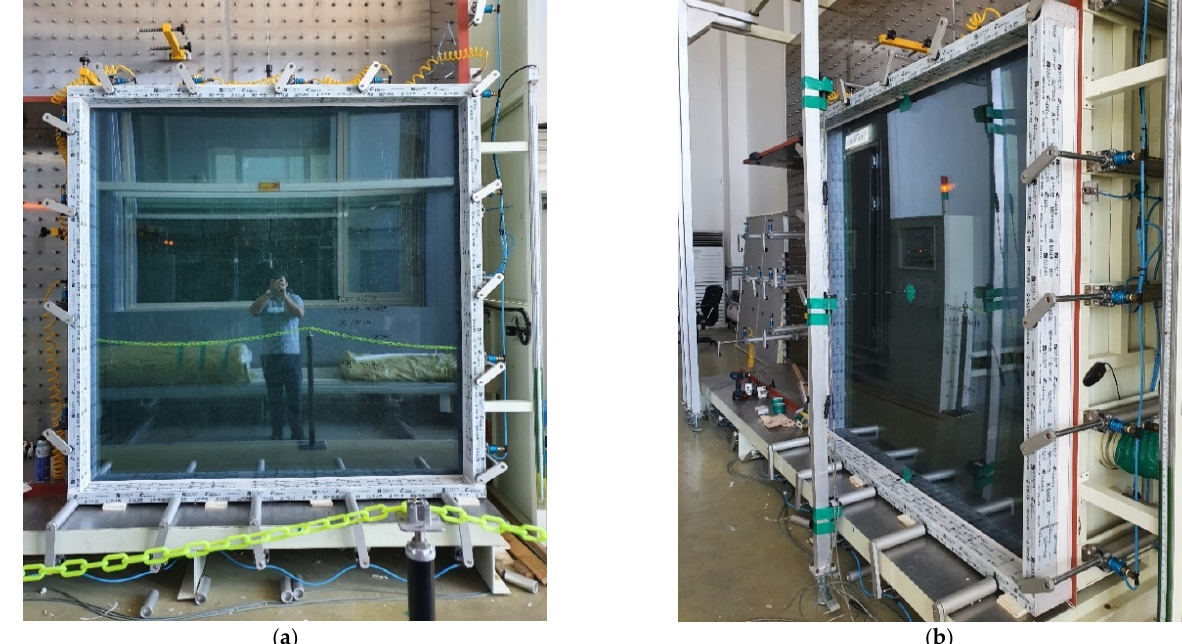
Figure 39. Specimens for evaluating watertightness and wind pressure performance: ( a ) watertightness performance evaluation specimen; ( b ) wind pressure performance evaluation specimen.